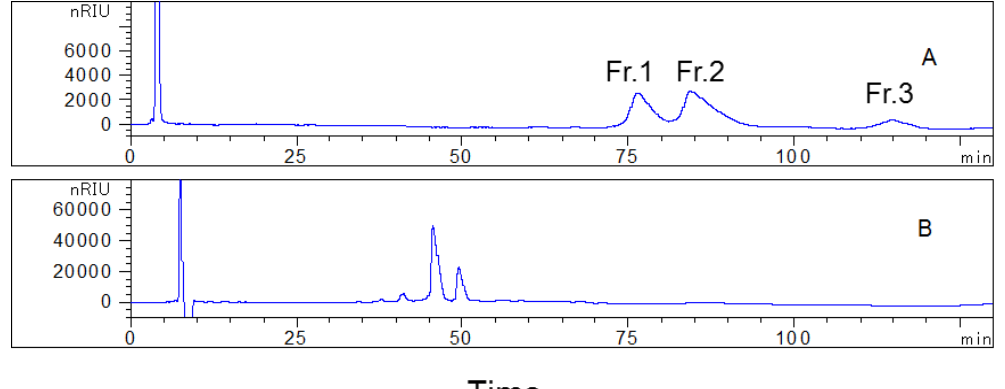
Figure1. HPLCpreparationchromatogramsoftheexamined sampleusingthe SenshuPakC 6 H 5 -3152-N Figure 1. HPLC preparation chromatograms of the examined sample using the Senshu Pak column (150 × 8 mm, A ) and the YMC-Pack ODS-AQ column (250 × 10 mm, B ). Conditions: mobile C 6 H 5 -3152-N column (150 × 8 mm, A) and the YMC-Pack ODS-AQ column (250 × 10 mm, B). phase: water and methanol (80:20, v / v ) and water–acetonitrile (82:18, v / v ) for ( A ) and ( B ), respectively; Conditions: mobile phase: water and methanol (80:20, v/v) and water–acetonitrile (82:18, v/v) for ( A ) flow rates: 1.5 mL / min and 2.0 mL / min for ( A ) and ( B ), respectively; column temperature: 30 ◦ and ( B ), respectively; flow rates: 1.5 mL/min and 2.0 mL/min for (A) and (B), respectively; column temperature: 30 °C.